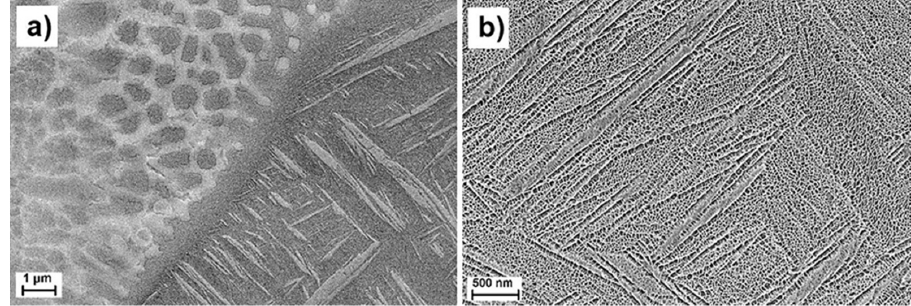
Figure 4. Microstructure of LPBF Ti6Al4V (ELI) ‐ 1 at % Cu alloy, ( a ) dendritic/cellular area with higher Cu content adjacent to martensitic region and ( b ) purely martensitic structure with lower Cu content.